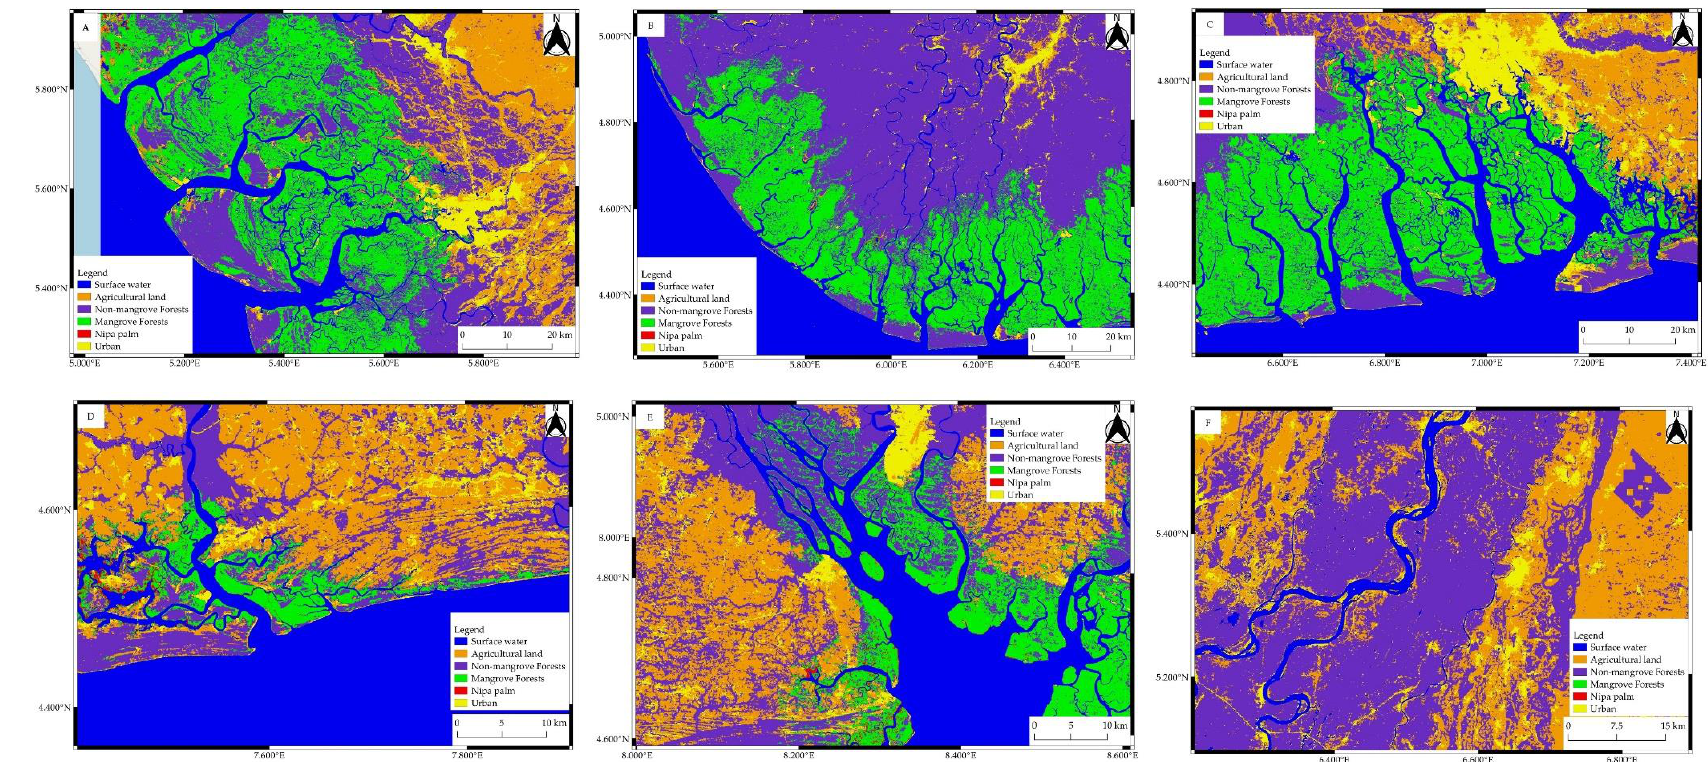
Figure 5. 2007 ( i ) and 2017 ( ii ) thematic map derived from the classification of layer stacked SRTM DEM, ALOS PALSAR, and Landsat 7 of the Niger Delta using SVM with Radial Basis Function Kernel. Inset ( iii ) shows the inland extent of mangrove forests from the 2017 classification in ( A ) western Niger Delta; ( B ) central Niger Delta; ( C ) eastern Niger Delta; ( D ) Imo River estuary; ( E ) Calabar estuary; and ( F ) the River Niger Basin bifurcation and the spread of surface water proximity to rain forests and agricultural land surrounding urban settlements.